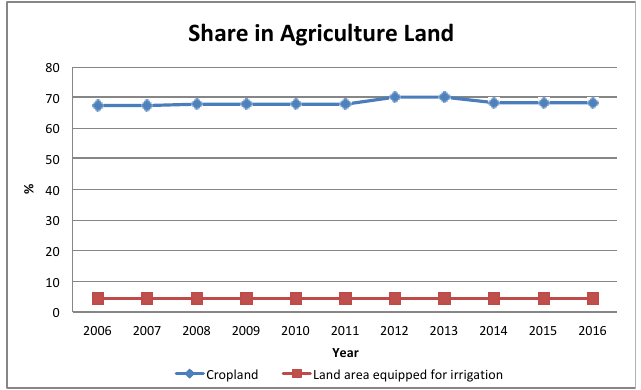
Figure 3 . Share in agriculture land regarding Cropland and Land area equipped for irrigation in Cabo Verde, from 2006 to 2016. Source: [49]. Cropland is the land used for cultivation of crops; Land area equipped for irrigation refers to the area prepared with irrigation infrastructure and equipment for crops.